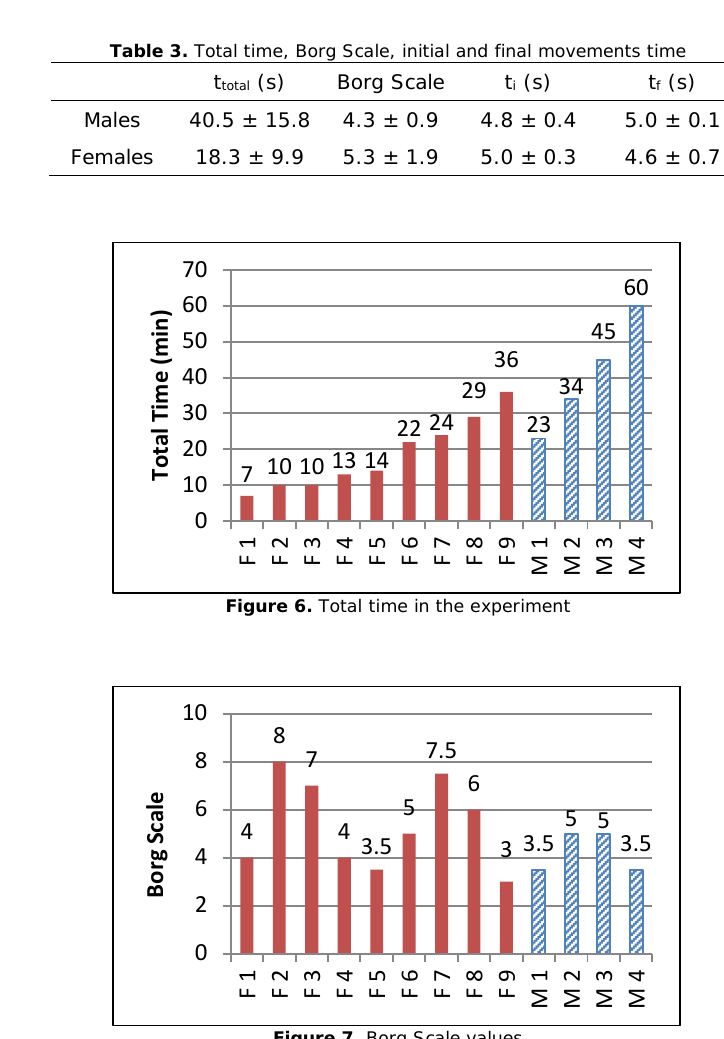
Figure 7 . Borg Scale